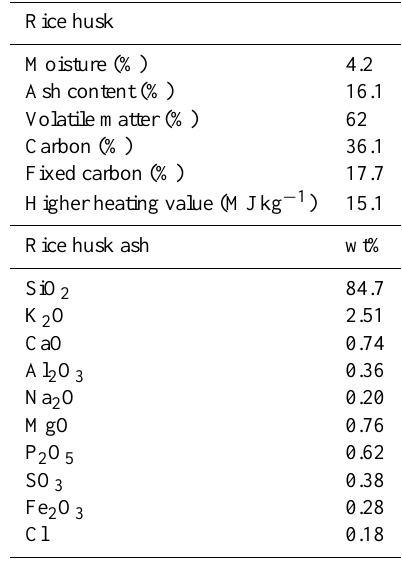
Table 1. Properties of the rice husk (used in this study) and rice husk